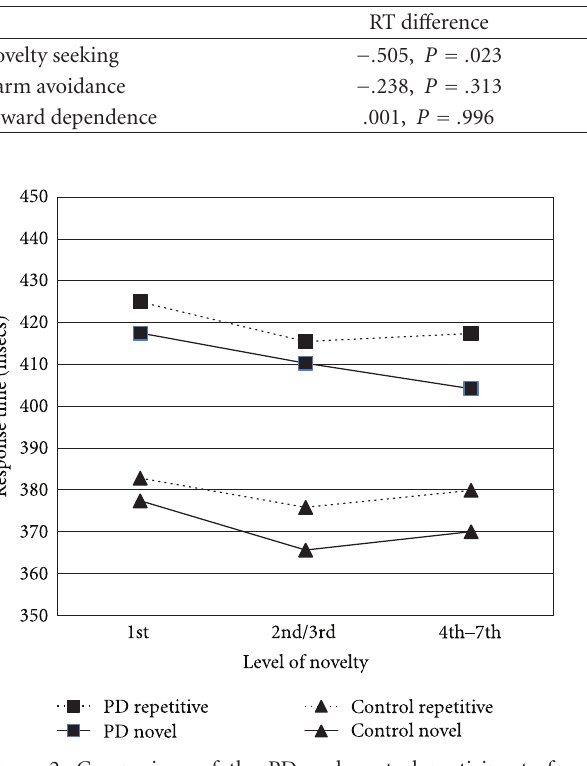
Table 2: Correlation coe ffi cients and P values for the associations between temperament dimensions in the PD sample with cognitive and a ff ective measures.